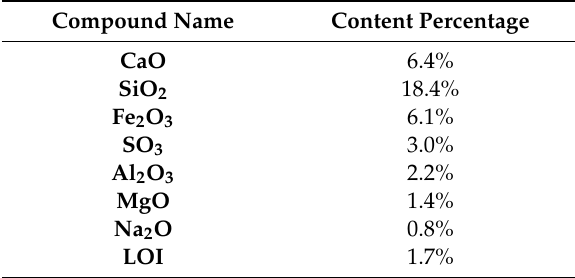
Table 1. Constituents of cement.